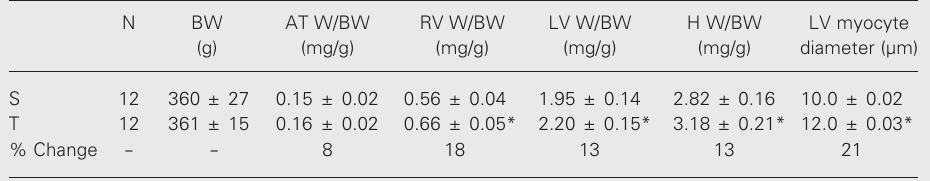
Data are reported as means ± SEM for 12 rats in each group. BW = body weight; AT W/BW = atrium weight to body weight ratio; RV W/BW = right ventricle weight to body weight ratio; LV W/BW = left ventricle weight to body weight ratio; H W/BW = heart weight to body weight ratio; LV, left ventricle. *P ≤ 0.05 compared to S rats (unpaired Student t